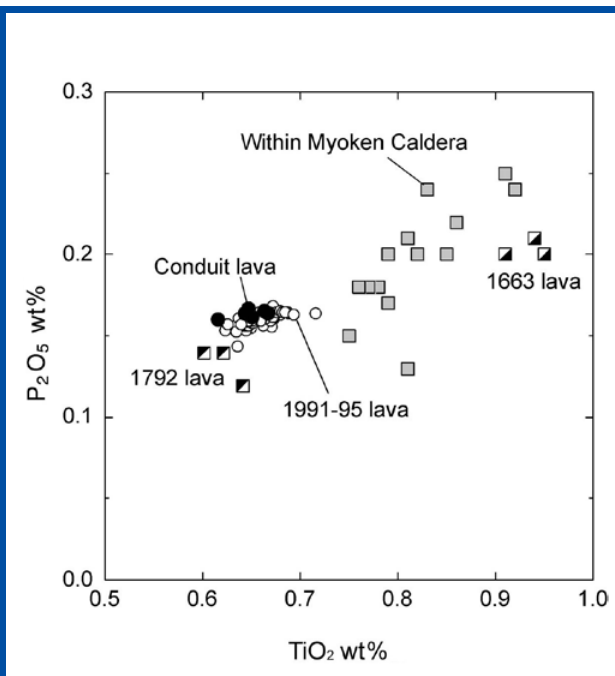
Figure 7. Chemical comparison of the conduit lava with lavas exposed at the summit area, including the 1991–1995 lava. All lavas inside the Myoken Caldera (see Fig. 1) are shown. Conduit lava samples are samples from cores 13 to 16 (Fig. 4).